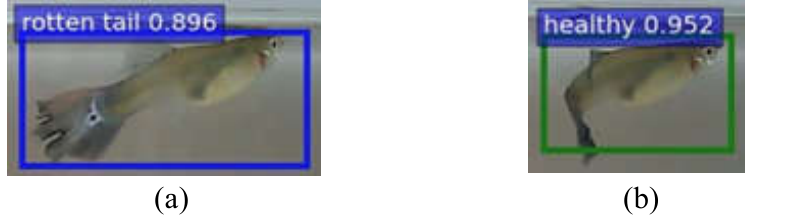
Figure 9. Fish flips over would easily lead to misidentification: ( a ) a rotten-tail fish and ( b ) misidentified as a healthy fish when turning around.